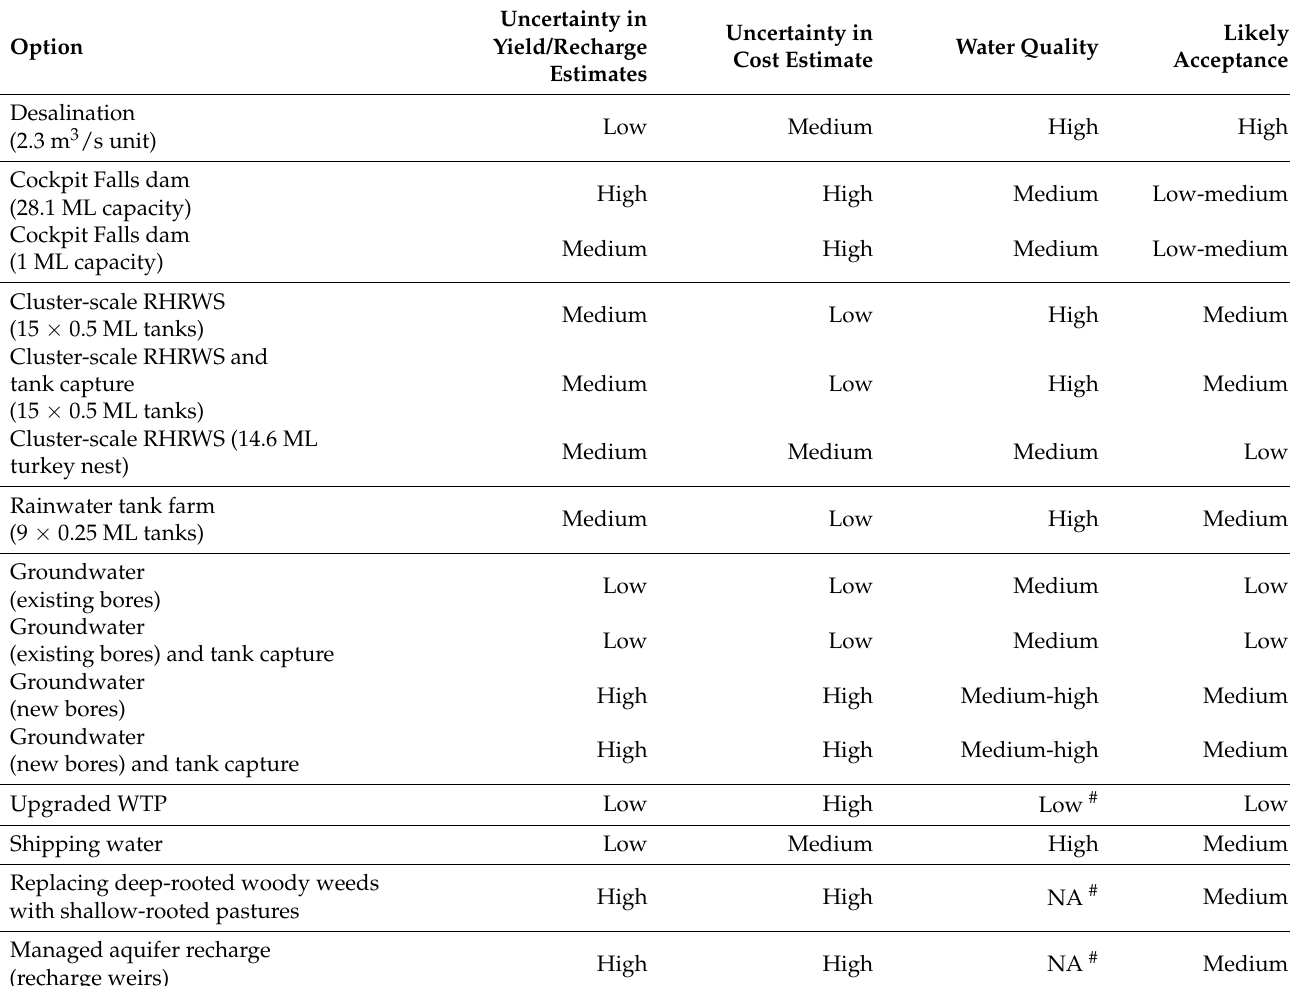
Table 9. Other considerations in evaluating intervention